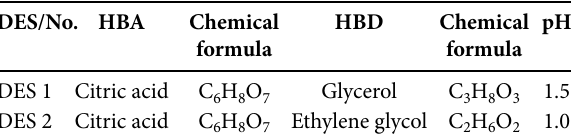
Table 1. Components and their properties used in the design of DES for the UAE of Rosa canina L. fruits DES/No.